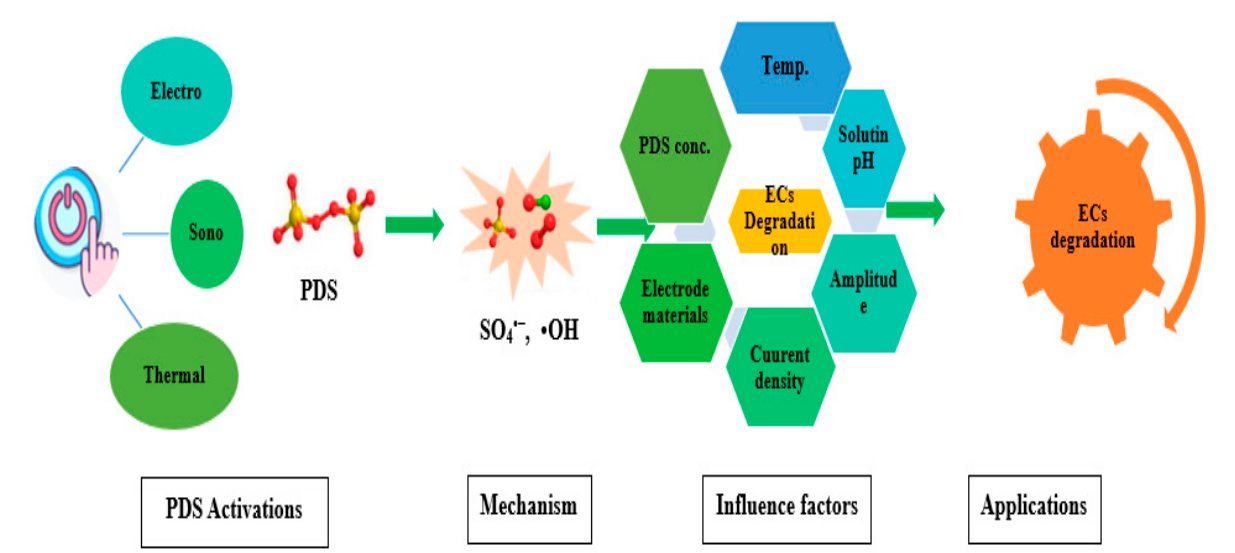
Figure 2. Activations methods of persulfate for ECs degradation.